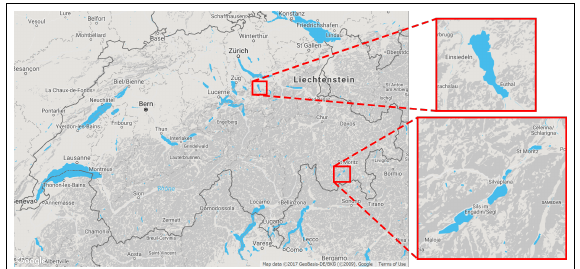
Figure 1: Left image: map of Switzerland with target lakes displayed in blue. The top-right image shows lake Sihl, the bottom-right image the region of lakes Sils, Silvaplana and St. Moritz (from left to right). Image courtesy of Google. Best viewed on